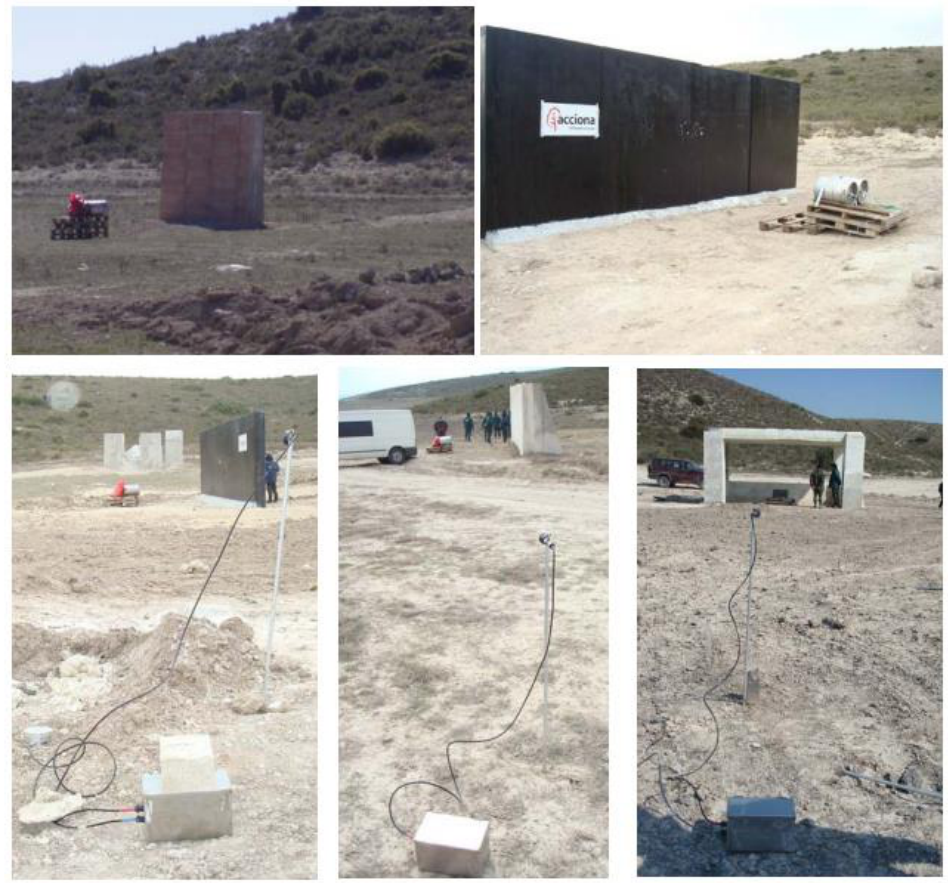
Figure 2. Charge locations in front of the different structures.